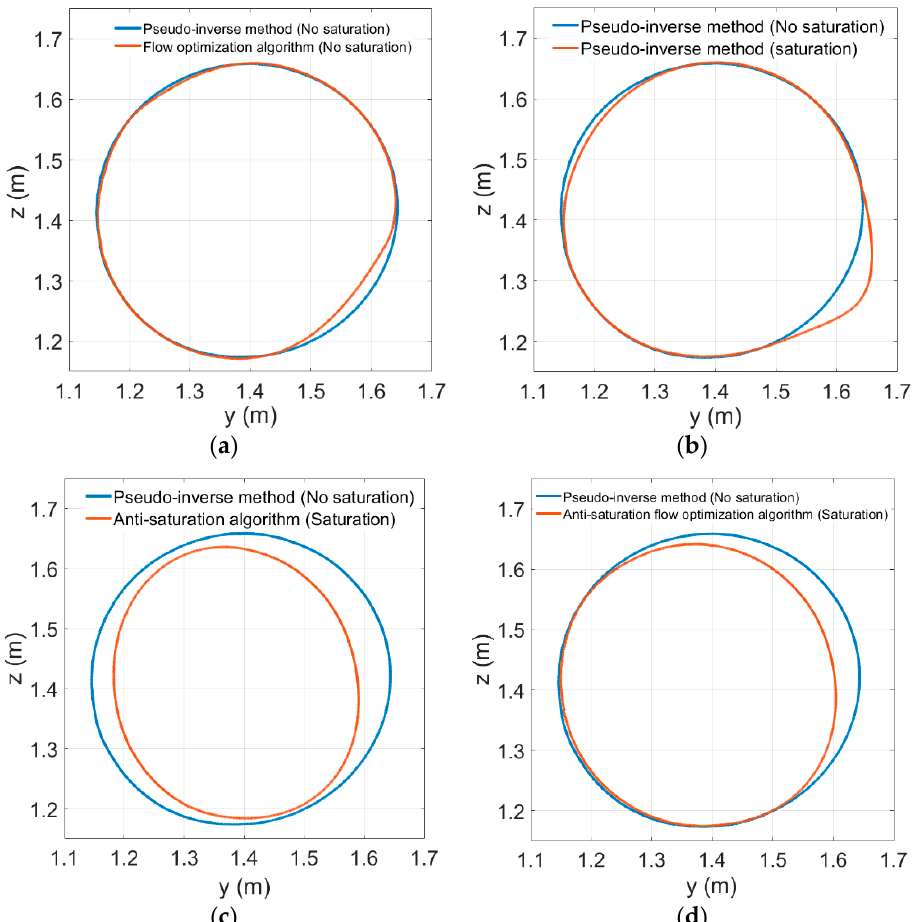
Figure 11. Comparison diagram of the endpoint trajectory in a same stable period. ( a ) Trajectory comparison of the flow optimization algorithm experiment; ( b ) trajectories comparison of the pseudo-inverse method experiment; ( c ) trajectory comparison of the anti-saturation algorithm experiment; ( d ) trajectory comparison of the anti-saturation flow optimization algorithm experiment.